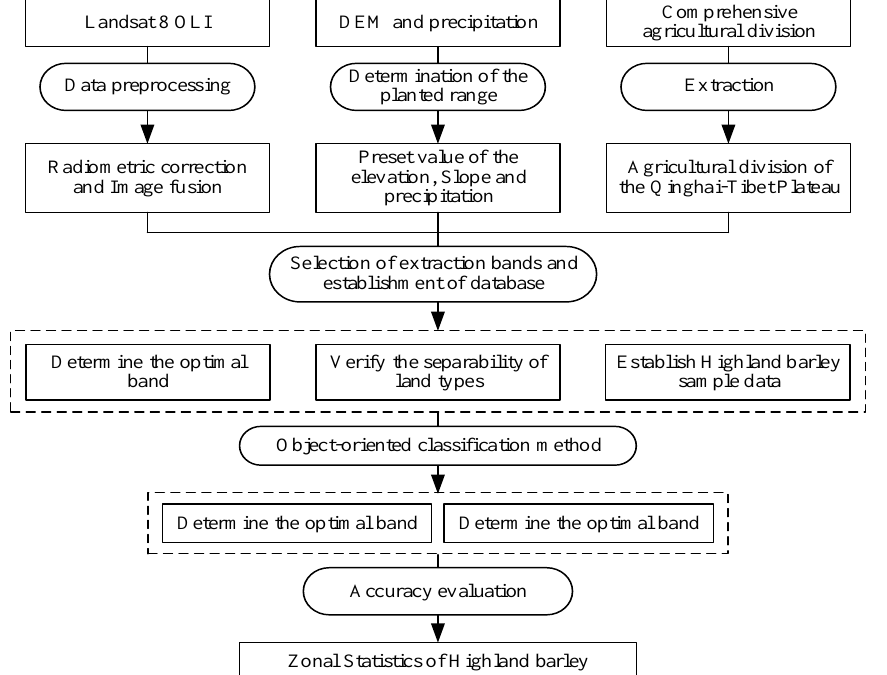
Figure 5. The extraction process of Highland barley in the Qinghai–Tibet Plateau.